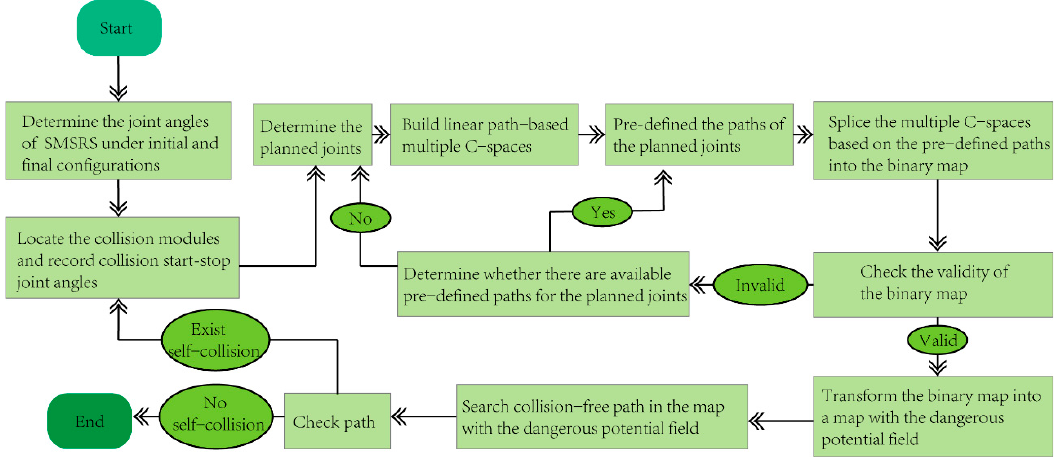
Figure 7. Steps of self-collision avoidance strategy of SMSRS.